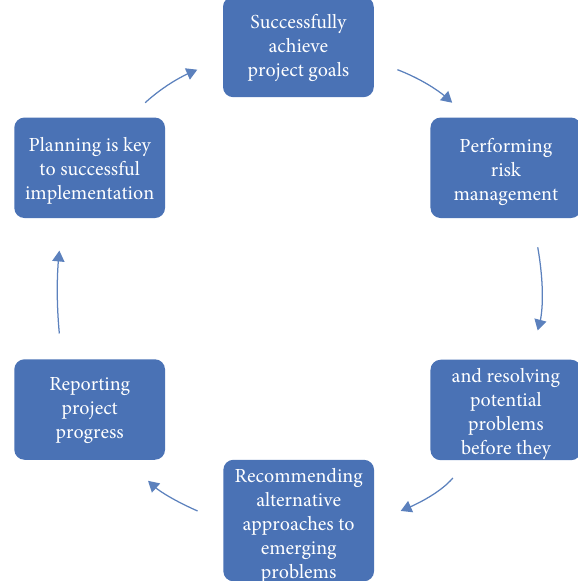
Figure 4: Energy directing